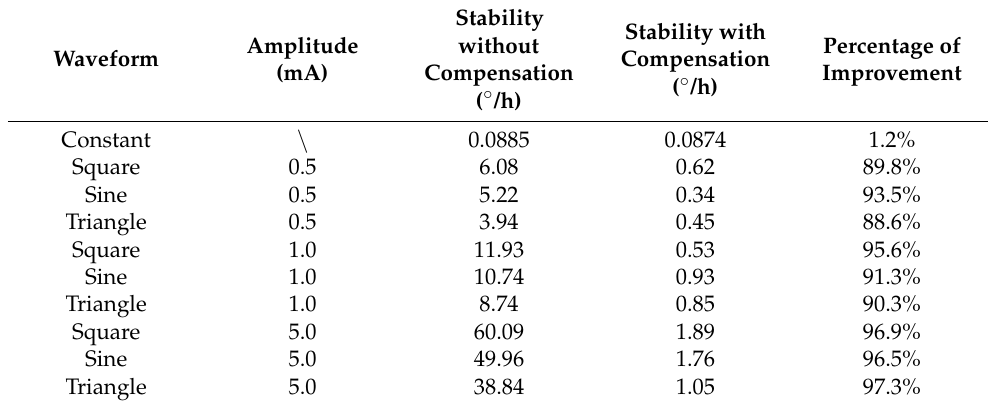
Figure 10. Measured effects on zero-bias stability and compensation results when the driving currents are modulated as square-, sine-, and triangle-waveforms that have the different amplitudes of 0.5 mA, 1.0 mA, and 5.0 mA. Table 2. Influence of SLD power fluctuation on zero-bias stability and compensation results.